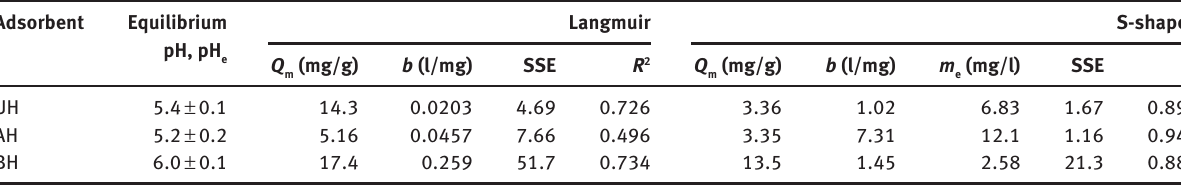
Table 2: Constants of isotherm models. Adsorbent